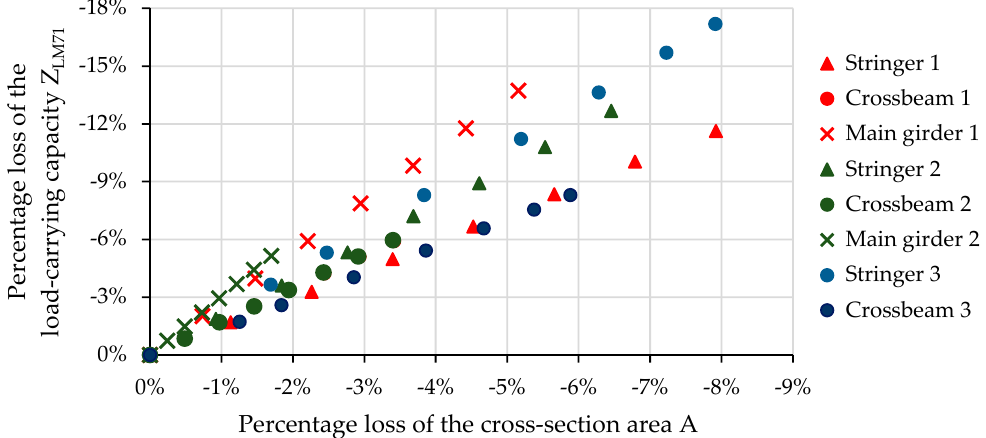
Figure 12. Relation between the losses of the cross-sectional area and load-carrying capacity due to corrosion.